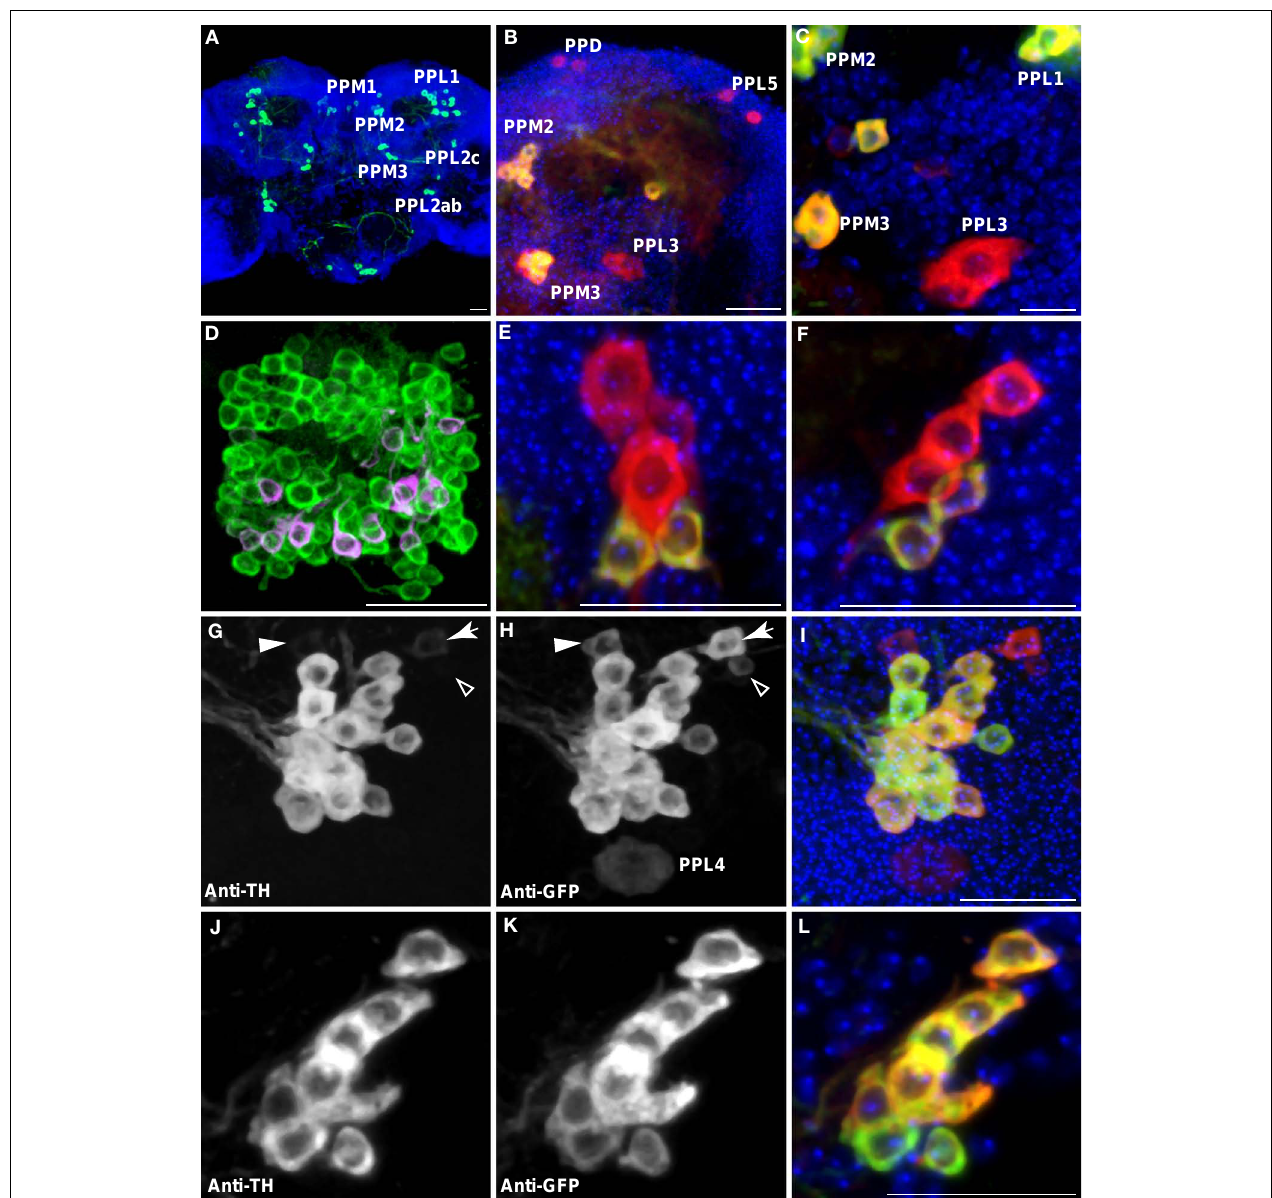
FIGURE 2 | Dopaminergic neurons as identifi ed by anti-TH staining compared with those identifi ed by TH-GAL4>UAS-mCD8::GFP expression. Medial is left in all panels except (A) and (E) which shows both hemispheres; dorsal is up in all panels. Panel (D) is an anterior view. All others are viewed from a posterior perspective. Scale bar in all panels: 20 µm. (A) Six clusters of neurons (green) were positive for anti-TH in the posterior protocerebrum. These correspond to the clusters PPM1, PPM2, PPM3, PPL1, PPL2c, and PPL2ab (Figure 1) . Blue, TOTO-3 staining cell nuclei in the brain. (B) In addition to the six clusters of cells identifi ed in (A) , TH-GAL4>UAS-mCD8::GFP expression was also observed in four groups of cells that are TH-negative, labeled as PPD, PPL5, and PPL3 in this panel and PPL4 in panel (H) . Green, anti-TH immunostaining. Red, TH-GAL4>UAS-mCD8::GFP , identifi ed with an anti-GFP antibody unless otherwise noted. Blue, TOTO-3. (C) The PPL3 cell is one large neuron lateral to the PPM3 cluster (partially shown) and ventromedial to the PPL1 group